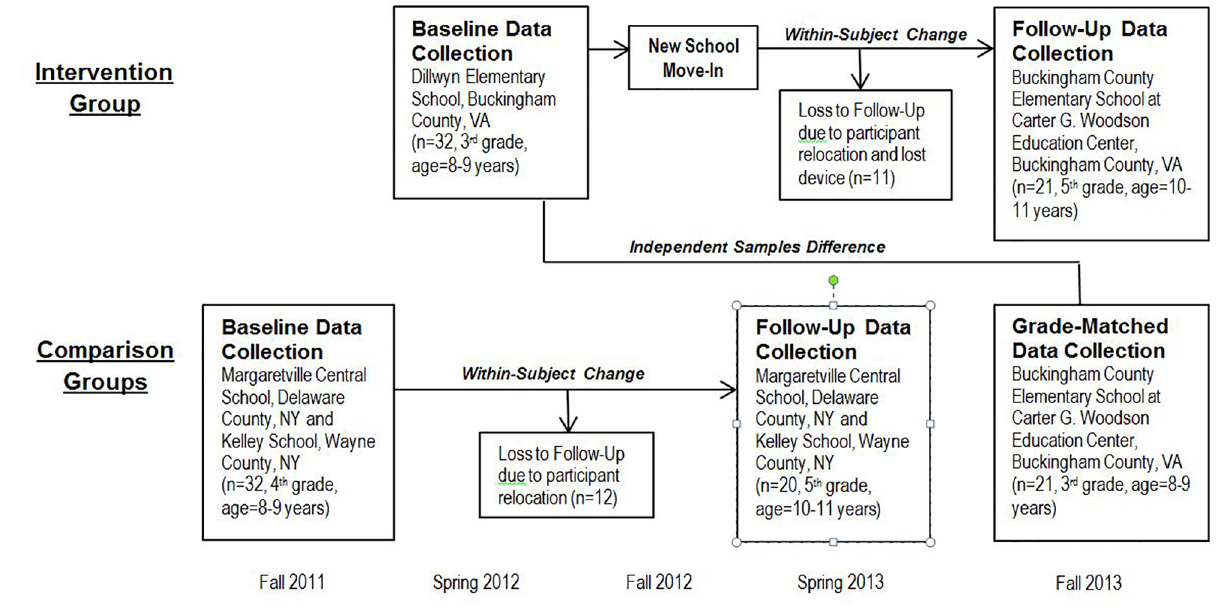
Fig 1. Researchdesign and flowchart of